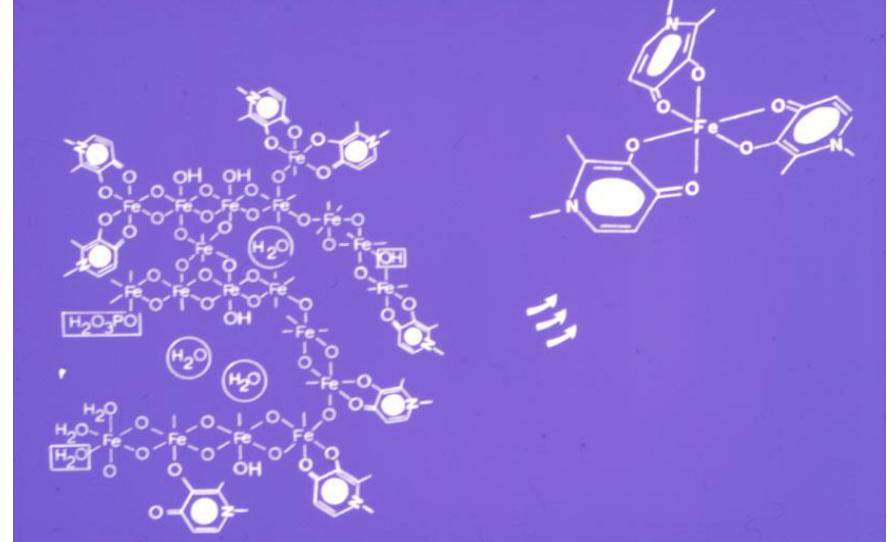
Figure 4. Iron mobilization from ferritin and hemosiderin by deferiprone (L1). Cartoon image of iron mobilization by L1, from the oxohydroxy polynuclear iron complex found in ferritin and hemosiderin. Iron binding by L1 begins from the outer surface of the iron core. Iron binding from the inner iron core is much more difficult to achieve due to lower accessibility by L1 and also because the polynuclear iron complex formation is much denser than the outer surface of the iron core.